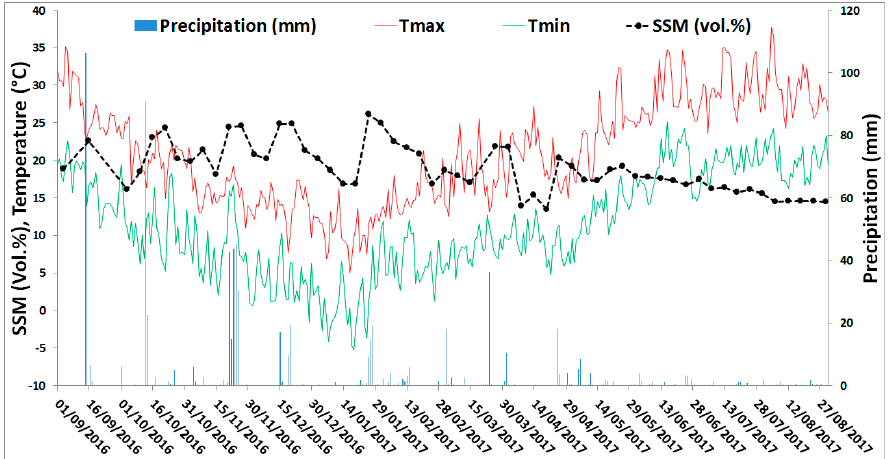
Figure 2. Temporal evolution of soil moisture values of Sentinel-1 derived surface soil moisture maps (S1-SSM) with daily precipitation records for a GPM grid cell over Montpellier ( 0.1 ° × 0.1 ° ), and daily temperature records (minimum and maximum temperature) at a local station in Montpellier, Occitanie region, France.